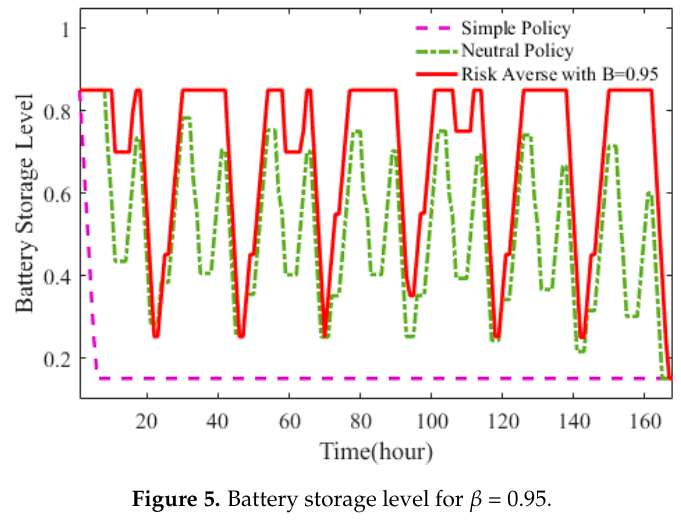
Figure 5. Battery storage level for β = 0.95.